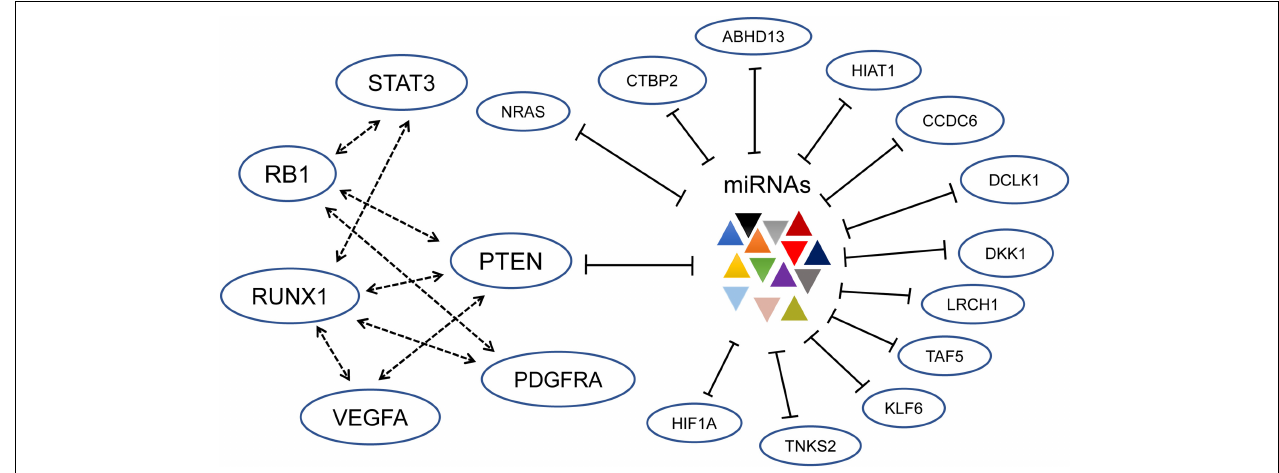
FIGURE 1 | Established driver genes of gliomagenesis constitute a complex ceRNET; especially the ceRNAs for PTEN are shown (Sumazin et al., 2011). Through shared miRNA, the six cancer driver genes including PTEN, RB1, STAT3, PDGFRA, RUNX1, and VEGFA regulate each other. At the same time, other genes constitute a subnetwork and interact with PTEN. The dotted arrows represent activation, and the lines with blunt ends indicate inhibition.